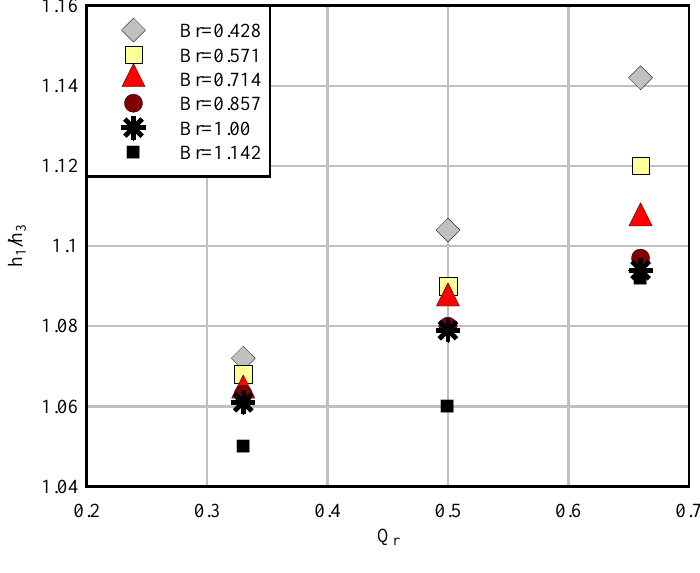
Figure 11. Q r vs. h 1 / h 3 for different B r .